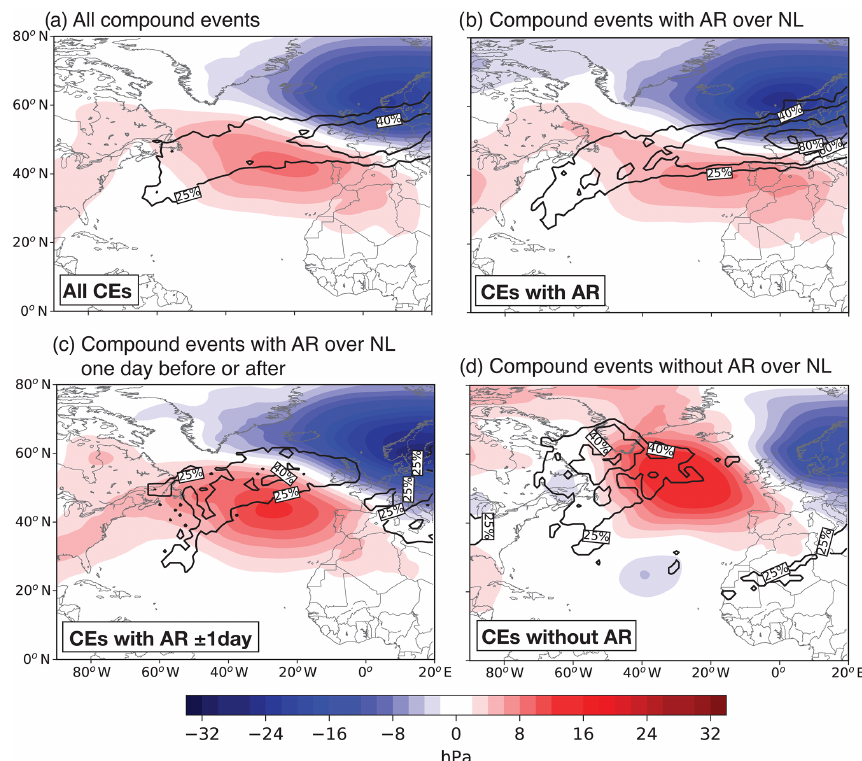
Figure 4. (a) Mean anomalies in daily mean sea level pressure (colour shading) and relative area covered by ARs during all compound events at Den Helder during the study period. Panels (b) , (c) , and (d) are the same as (a) but for CEs occurring on days (b) with an AR over the Netherlands, (c) 1 day before or after a day with an AR over the Netherlands and (d) without AR over Netherlands within a 3-day period centred around the